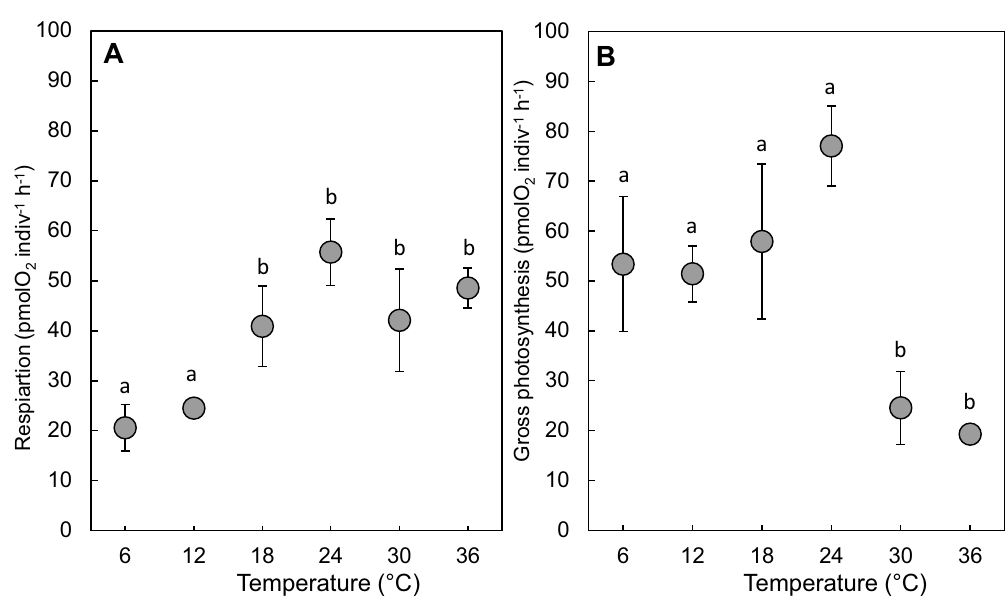
Figure 4. Temporal changes in the mean velocity of 9 H. germanica individuals previously exposed at ( A ) 6 °C then 18 °C and ( B ) 36 °C then 18 °C. The grey line is the instantaneous velocity and the red line is the 3-order simple moving average of the velocity. Yellow triangles correspond to water-temperature changes through time.